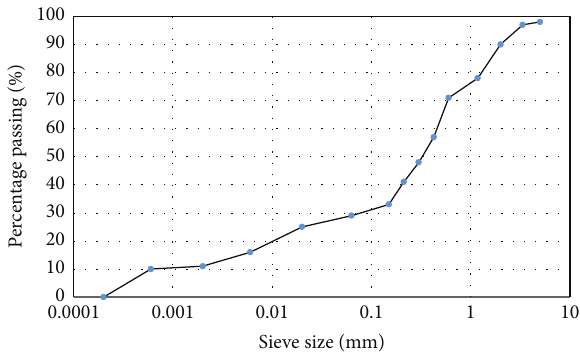
Figure 1: Particle size distribution of experimental soil.